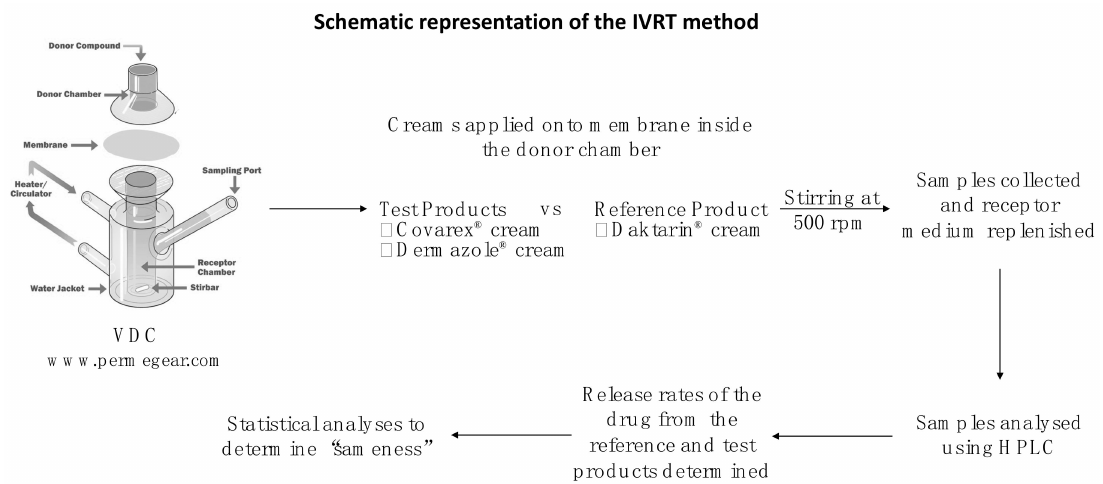
Figure 1. Schematic representation of the IVRT method used to assess “sameness” / di ff erences between creams containing 2%